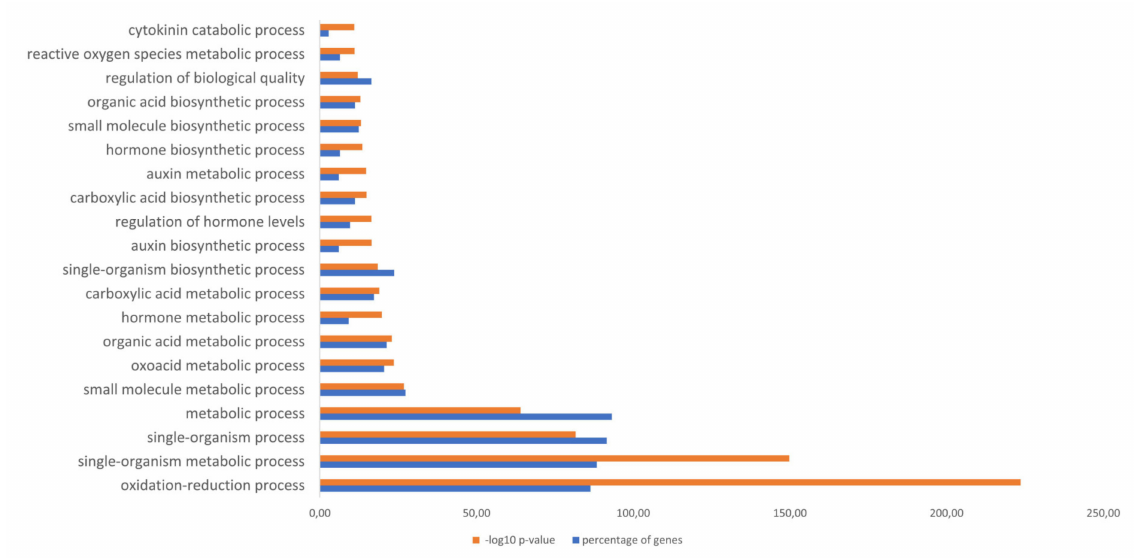
Figure 5. GO term enrichment of the flavoproteome of Arabidopsis thaliana . Orange represents the 20 highest log10 p-values of the enriched AGI numbers from Table S1 tested against the background database The Arabidopsis Information Resource (TAIR) genome locus (TAIR10_2017). The blue labeling represents the percentage of genes derived from all of the 249 genes of Table S1. The p-value cut o ff is p < 0.05. The complete GO term enrichment can be found in Table